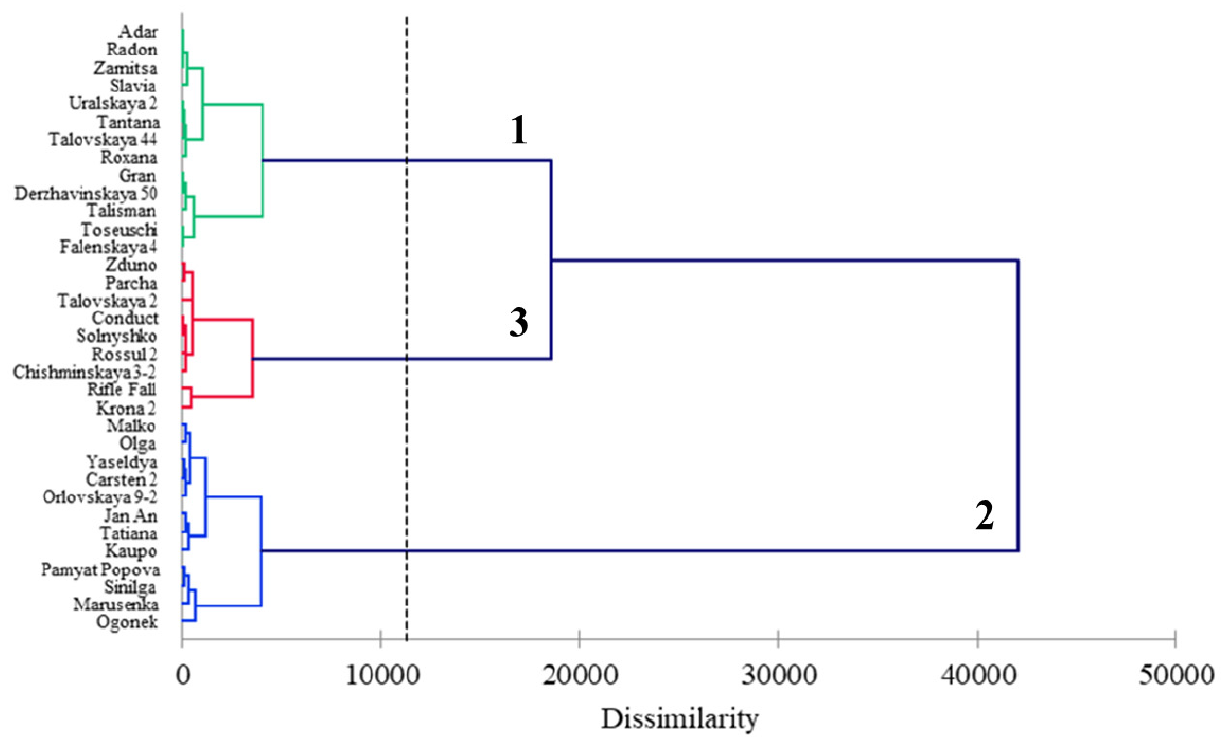
Figure 5. Hierarchical agglomerative clustering of 34 rye accessions, based on the parameters of snow mold damage, assessed under a natural infection background (NIB) and an artificially-enriched infection background (AIB) in the field, as well as under laboratory conditions following Microdochium nivale infection using a detached leaf assay. Clustering was performed using Ward’s method; the proximity between objects was measured by the criteria of dissimilarity based on Euclidian distance. Table 5. The characteristics of clusters arranged based on the parameters of snow mold damage of 34 rye accessions assessed under a natural infection background (NIB) and an artificially-enriched infection background (AIB) in the field, as well as under laboratory conditions following Microdo- chium nivale infection using a detached leaf assay yielding index susceptibility (IS), mean percent of leaf infestation (LI), and mean percent of disease incidence (DI).